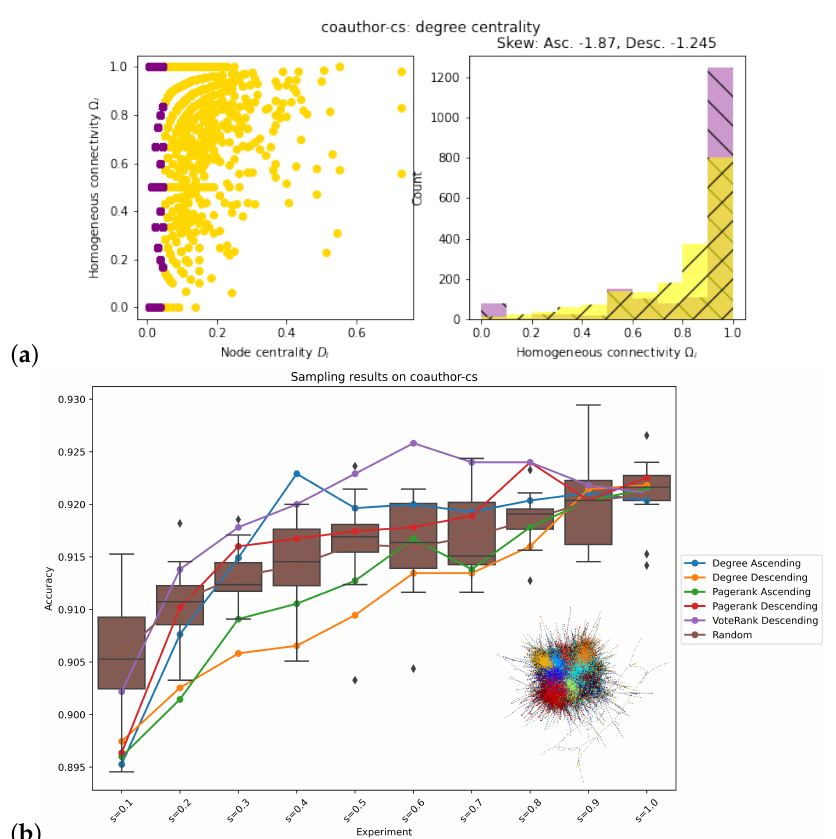
Figure A3. Panel ( a ) shows degree centrality plots where the left figure presents scatter plots of node degree centrality D i against node homogeneous connectivity Ω i on the training data of coauthor-cs. The upper half of nodes according to their centrality are colored in yellow while the lower half is presented in purple. The histogram on the right visualizes the distribution of homogeneous connections. The skew for each subset’s distribution is annotated above the right graph. Panel ( b ) presents the sampling result on the training data of